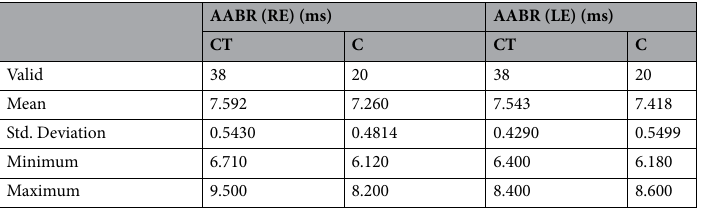
Table 1. Descriptive analysis of the wave V findings of the AABR in the study groups. AABR automated brainstem auditory response; RE right ear; LE left ear; ms milliseconds; CT congenital toxoplasmosis group; C control